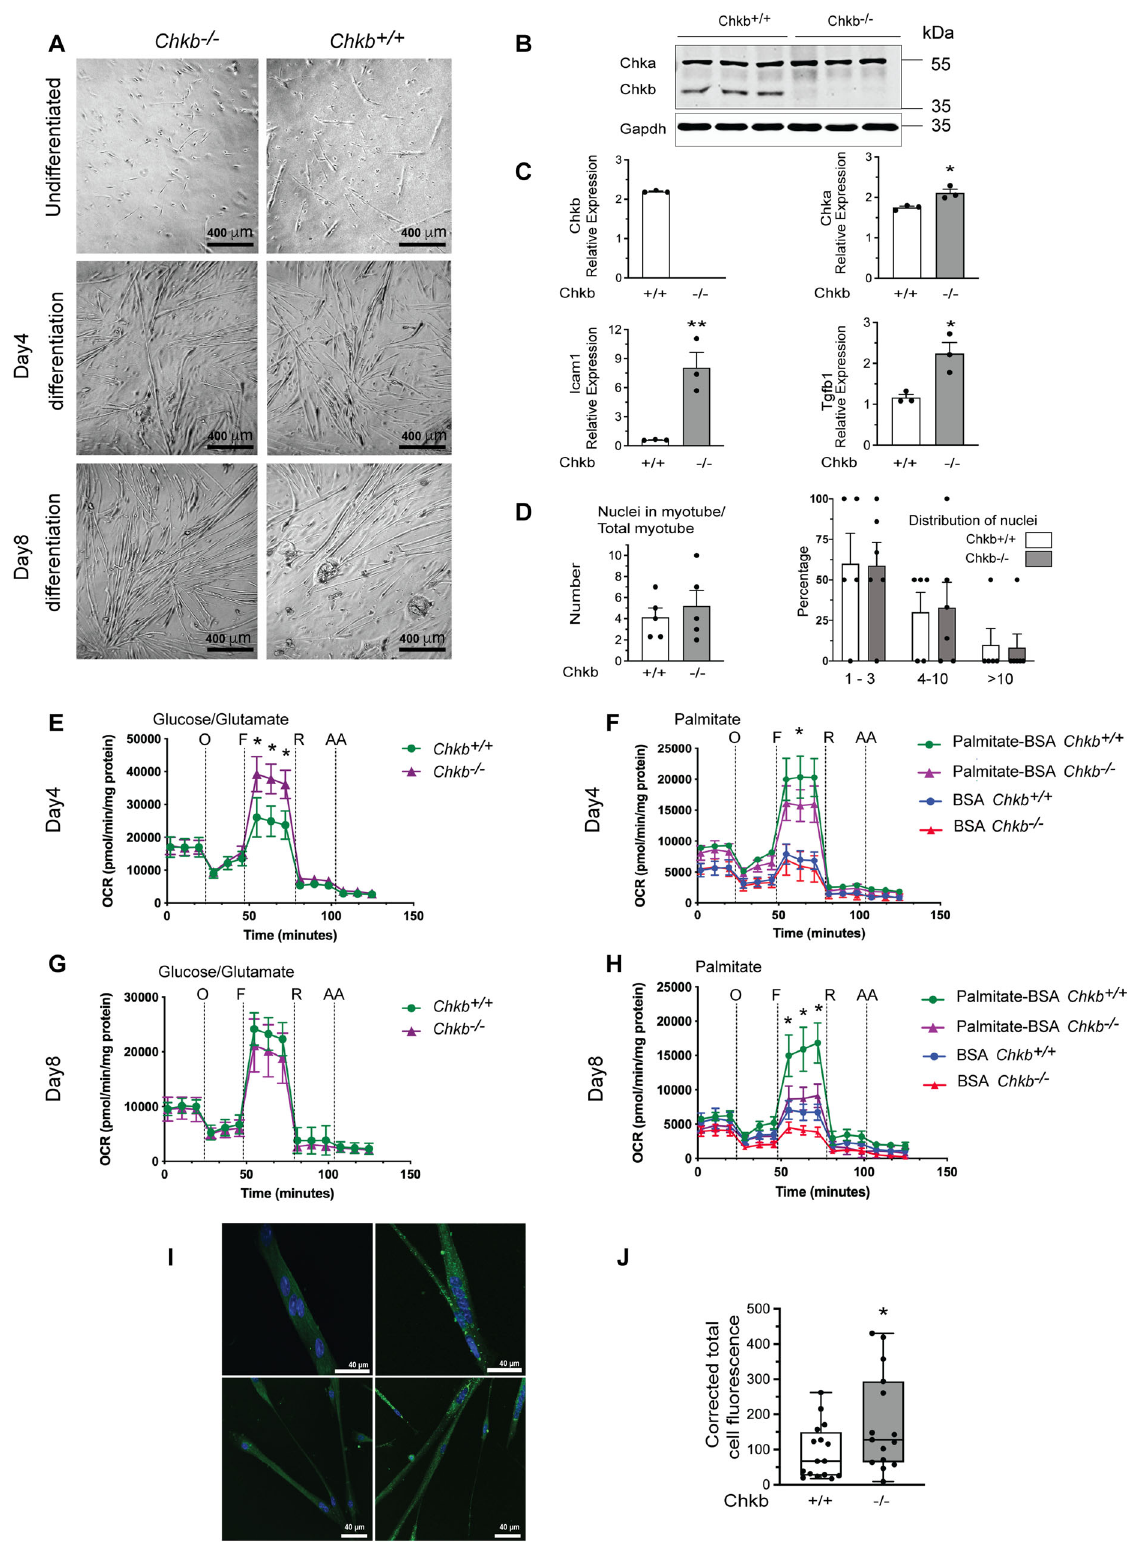
analysis of mitochondrial respiration in Chkb − / − myocytes where reduced fatty acid oxidation capacity progressively decreased over time. As Chkb − / − mice aged, AcCa level in hindlimb muscle returned to wild type and by 30 days a dramatic 12-fold increase in TG level was observed. The increase in TG level is consistent with impaired use of fatty acids by mitochondrial β